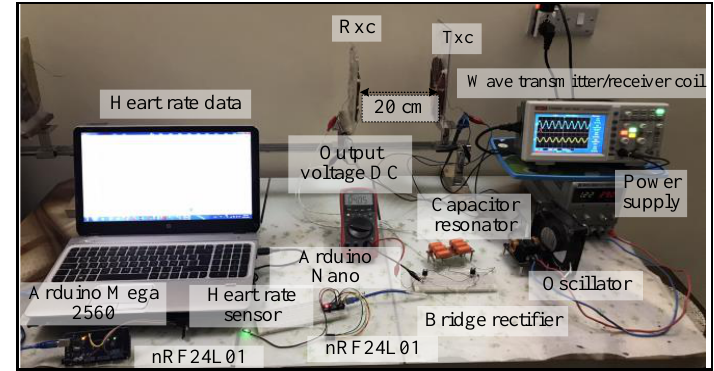
Figure 7. A snapshot of the MRC system at 20 cm for the second topology for real time.